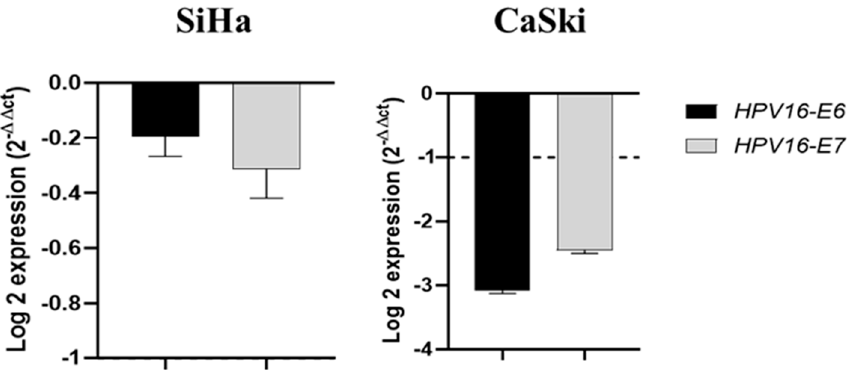
Figure 5 . Piperine reduces the expression of HPV16 oncogenes in CaSki cells. Graphs of HPV16-E6 and HPV16-E7 mRNA expression after piperine treatment compared with the control in SiHa and CaSki cells. The dotted line ( ≥ 1.0 or ≤− 1.0) is equivalent to the difference of the significant expression based on logarithm 2.